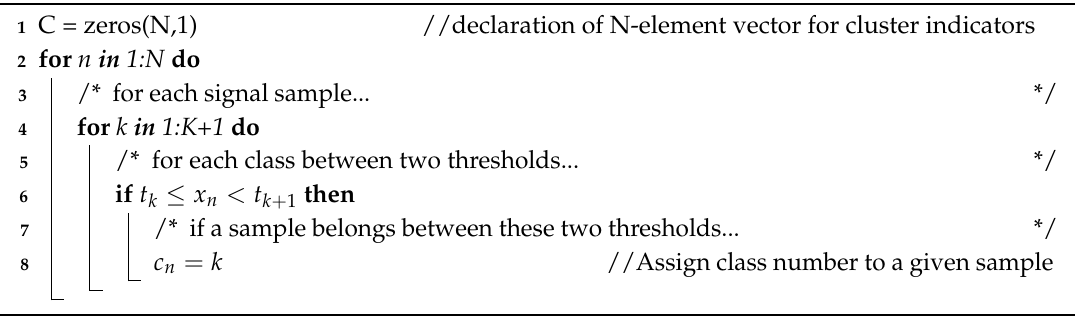
Algorithm 1: Threshold-based